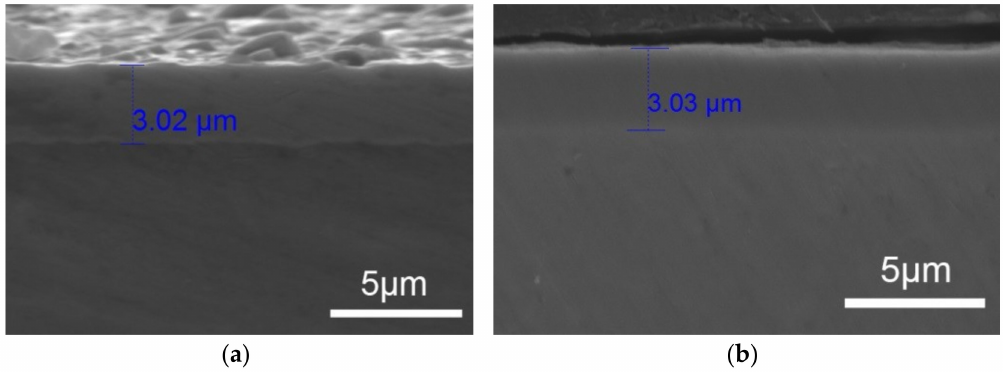
Figure6. Cross-sectionSEM test resultsof CrN and TiNcoated samples. ( a ) CrN coating, ( b )